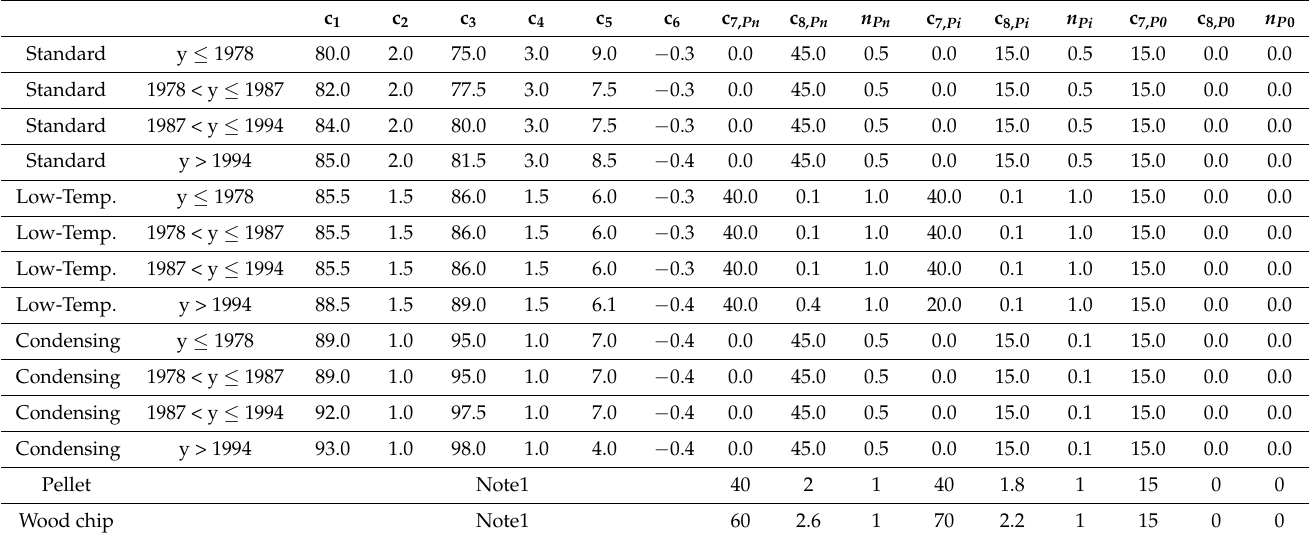
Table A3. Coefficients for the calculation of default values for SH